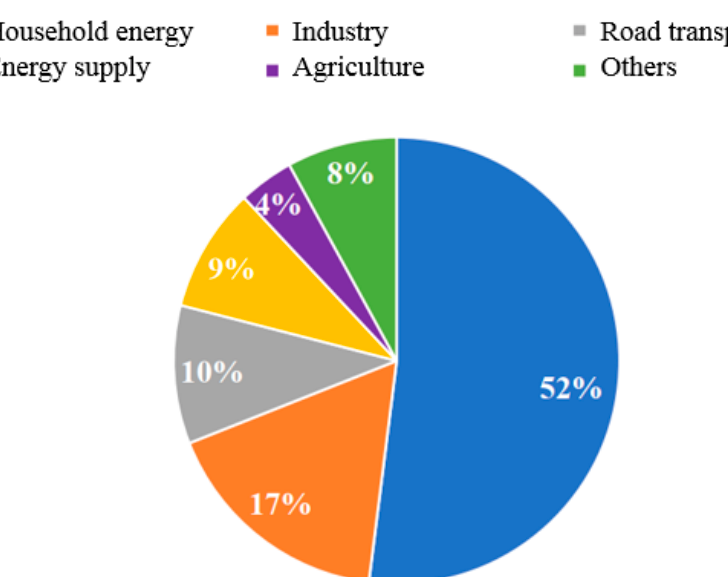
Figure 1. Air pollution sources in Polish cities, based on [1].